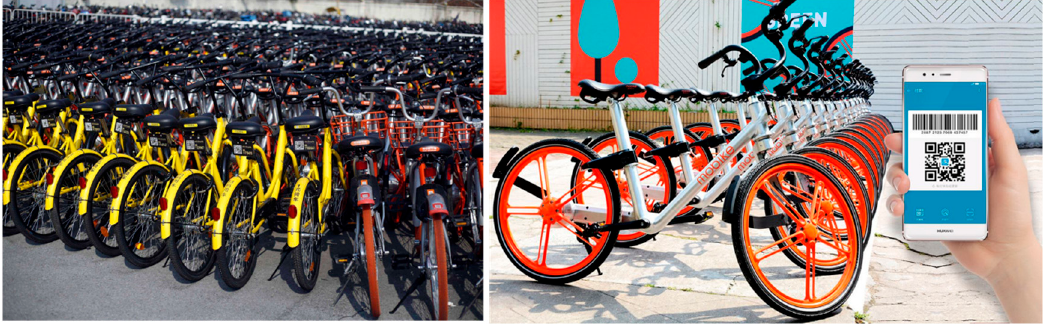
Figure 1. Free-floating bike sharing (FFBS).